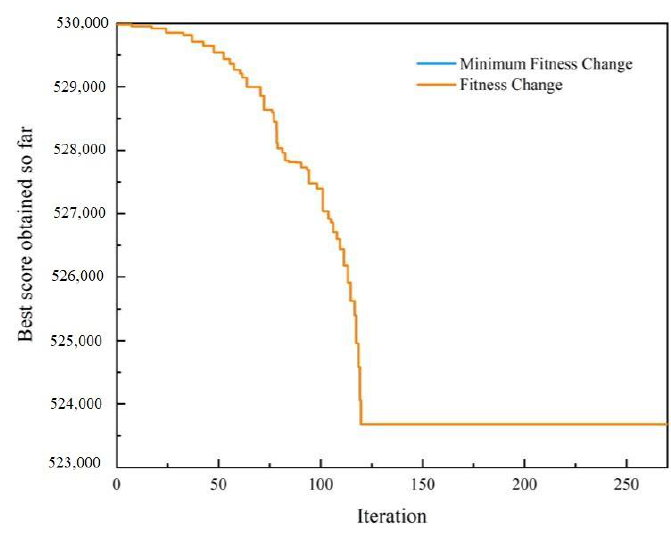
Figure 13. Schematic diagram of iterations of the PSO algorithm.